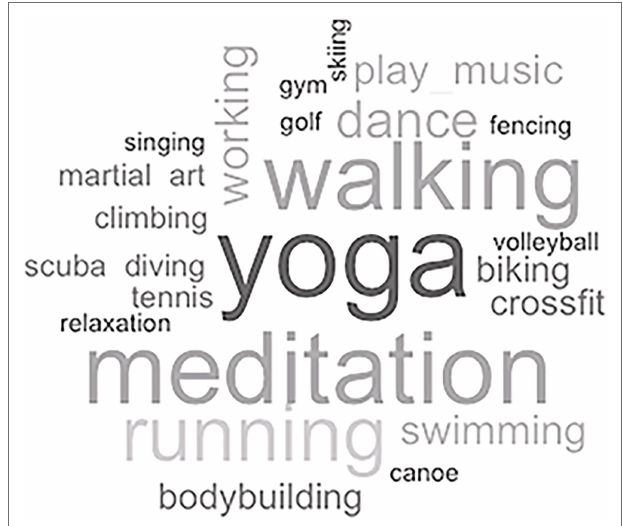
FIGURE 3 | Word cloud of body-centered activities that were reported in our sample based on their relative frequency. The bigger the word, the greater the frequency influences. The figure is a representation of words that have been entered at least more than twice (minimum frequency =